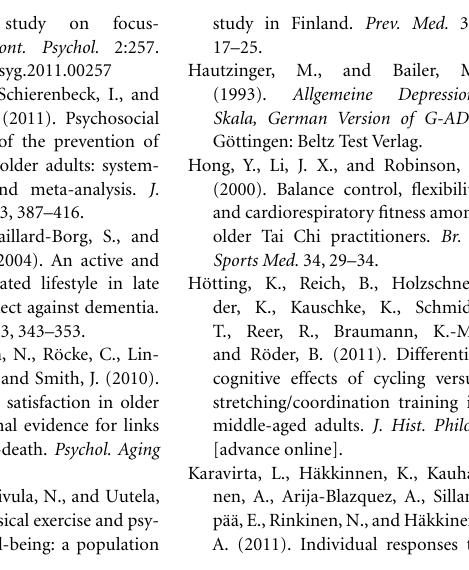
positive trends in cognitive speed for the cognitive training group (number–symbol test and number-connection test), the phys- ical exercise group (number-connection test), and in memory performance for the karate group (digit-span test and form- identification test). At the first glance this is astonishing that there are no significant results when compared with the literature,which has found an improvement after cognitive (Stine-Morrow et al., 2008) as well as physical training (Colcombe and Kramer,